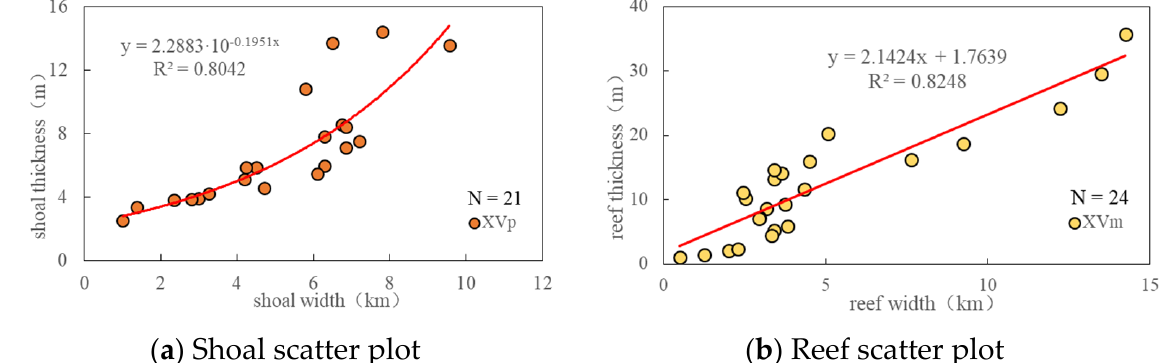
( a ) Shoal scatter plot ( b ) Reef scatter plot Figure 5. Scatter plot of thickness and width of ( a ) shoal and ( b ) reef. Figure 5. Scatter plot of thickness and width of ( a ) shoal and ( b ) reef. The log-linear formula for the shoal body is: L = 2.2883 × 10 − 0.1951H (3) in which L is the thickness of the shoal in m and H is the width of the shoal in km. The linear formula for the reef is: L = 2.1424H + 1.7639 (4) in which L is the thickness of the reef in m and H is the width of the reef in